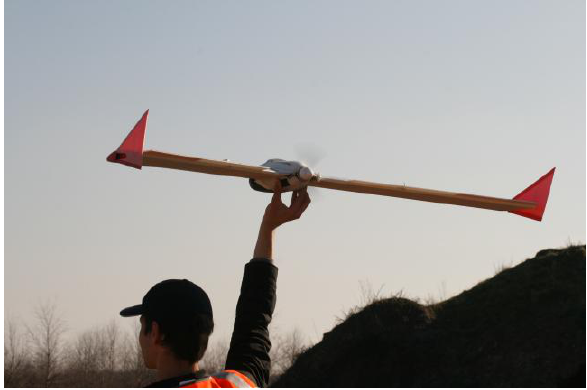
Figure 4 Hand start to a flight mission in NL